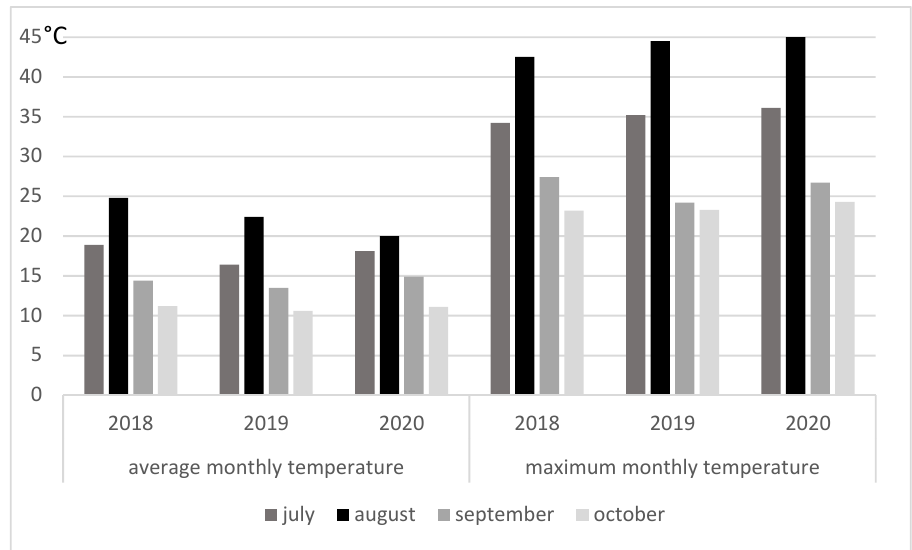
Figure 1. Average and maximum monthly temperatures during the day measured in the green mass of strawberry plants (°C).